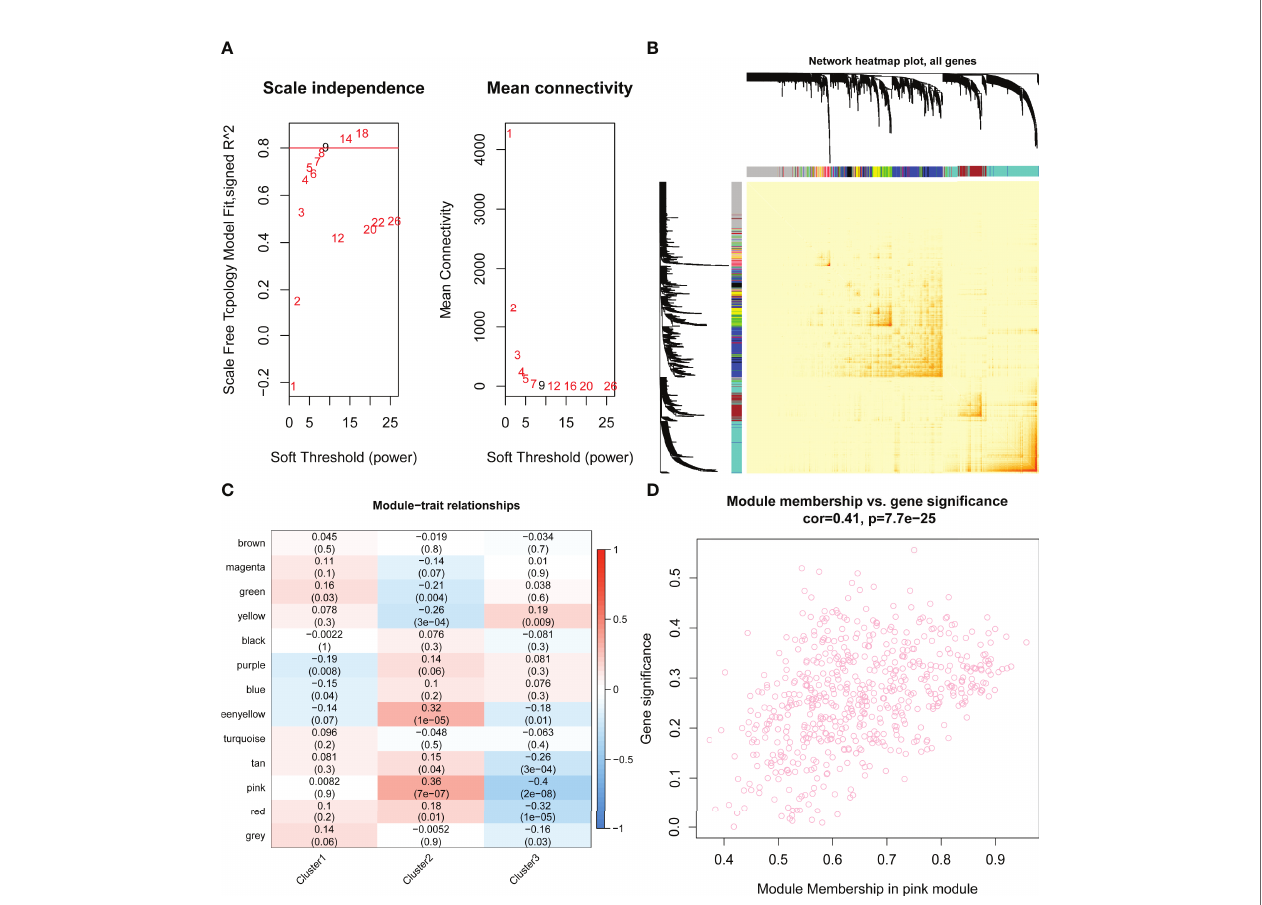
FIGURE 7 | Identi fi cation of hub pyroptosis-related gene modules by performing weighted gene correlation network analysis (WGCNA). (A) Scale independence and mean connectivity analysis for various soft threshold powers, where the optimum power = 9. (B) Network heat map plot of topological overlap for all genes. Each row and column correspond to a gene. The color row underneath the dendrogram indicated the module assignment, of which 13 modules were identi fi ed according to the dynamic tree cut. (C) The module – trait relationships between the 13 modules and three clusters are shown in the heat map. The most signi fi cant relationship was between the pink module eigengene and cluster 2 (Cor = 0.36, P = 7e-07). (D) The scatter plots of module membership in pink module vs. gene signi fi cance in cluster 2 (Cor=0.41, P=7.7e-25). Cor,